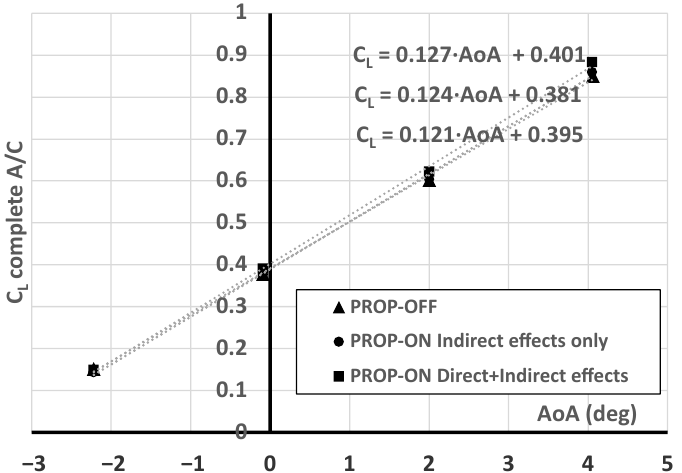
Figure 17. Indirect and direct propulsive effects on lift coefficient curves, experimental results, Re = 315,000, (CR) RPM 8750, X CG at LE MAC.